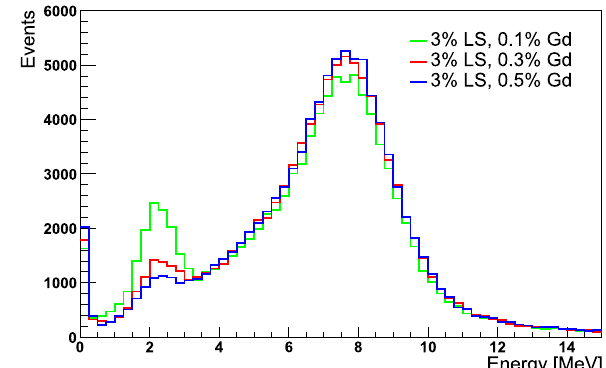
Fig. 5 Photo-electrondistributionsof E prompt forseveralWbLScock- tails (1%, 3%, and 5% LS)